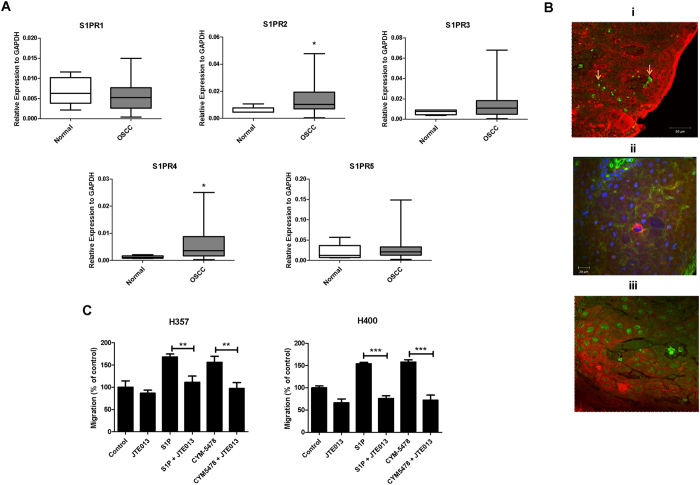
S1PR expression and role of S1PR2 in migration.(A) Box plots show expression of each S1PRs in normal individuals and OSCC patients as determined by QPCR. Expressions are normalised to GAPDH. *ρ < 0.05 (Mann Whitney U test). (B) Immunohistochemical evaluation of S1PR2 expression in normal and malignant tissues. Tissues were dual stained with pan-cytokeratin (Cy3, red) and S1PR2 (flourescein, green) antibodies. i. Normal tonsil showed weak nuclear staining in the stratified epithelium; occasionally moderate nuclear staining was also observed in normal epithelium. Red blood cells within the epithelium stained strongly for S1PR2 (arrows) and served as positive internal controls. ii and iii. Two separate well-differentiated OSCCs showing strong S1PR2 staining. The staining was cytoplasmic and focally membranous (ii) or nuclear (iii). (C) Transwell assays were performed in the presence or absence of 5 μM S1P, 5 μM JTE013 and/or 5 μM CYM5478 in the lower chamber. Results are expressed as percentage of migrated cells in the untreated control (=100%) ± SD. ***ρ < 0.001 and **ρ < 0.01 (unpaired T-test).